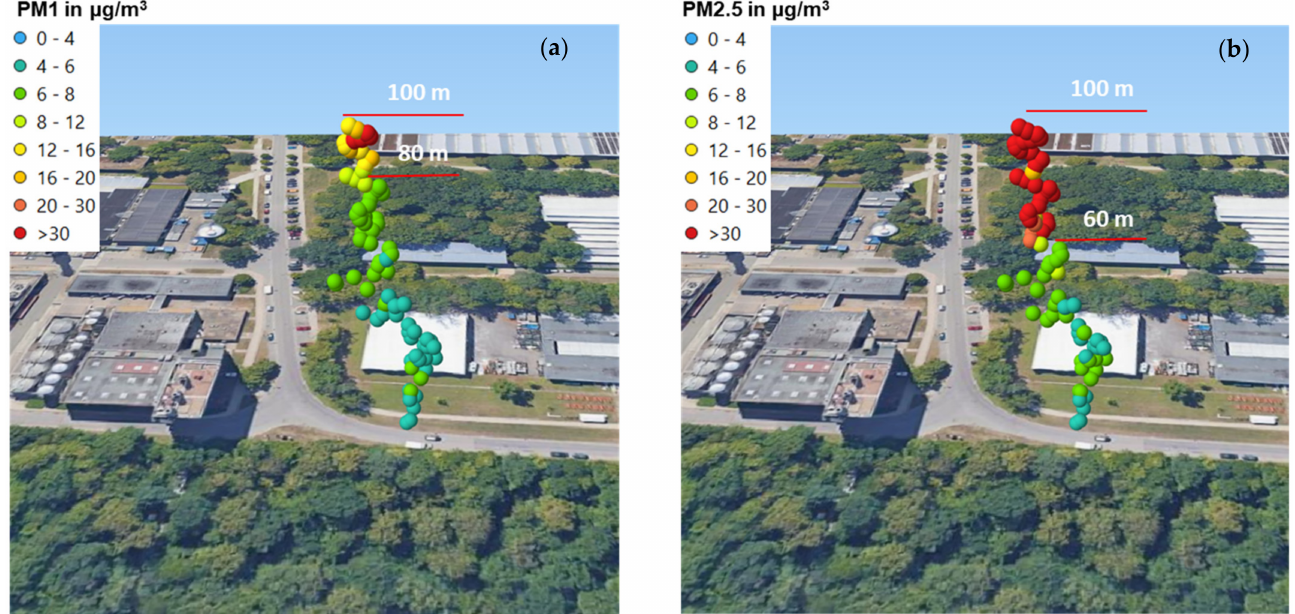
Figure 9. Three-dimensional visualization of the average concentrations of ( a ) PM1 and ( b ) PM2.5 during the three ascents performed in the field test on 23 January